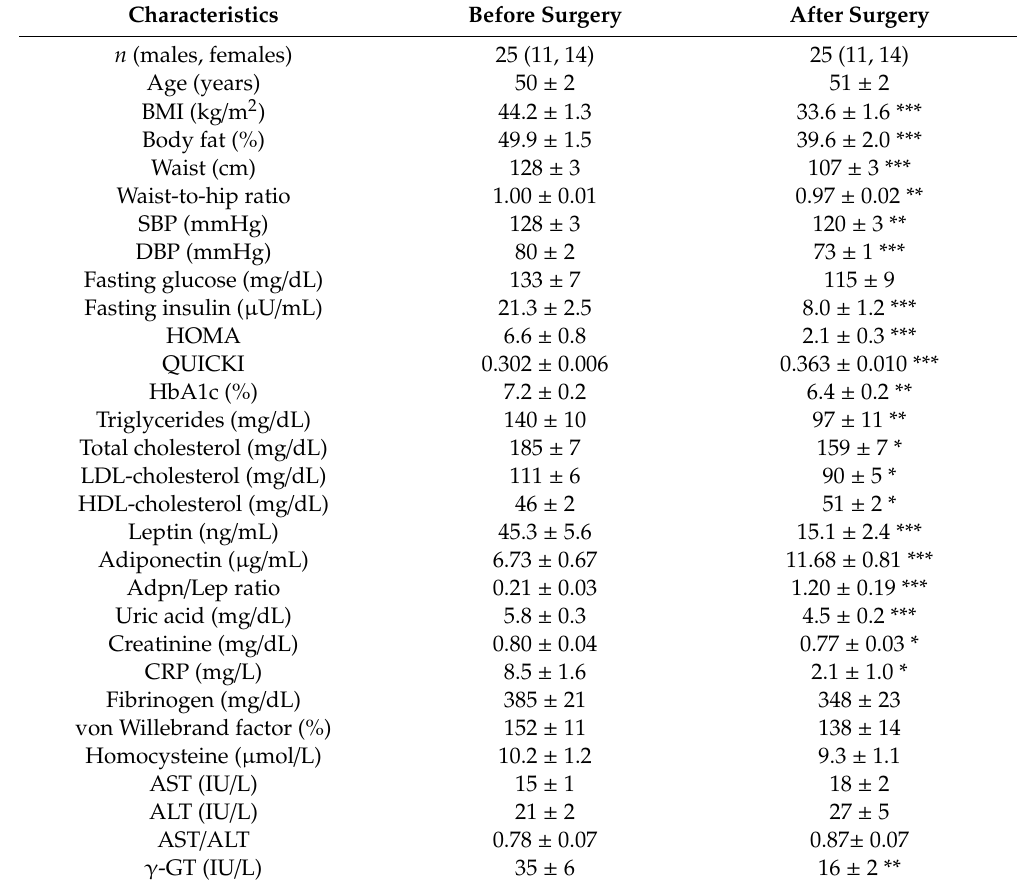
Table 1. Anthropometric and metabolic e ff ects in patients with obesity and type 2 diabetes (T2D) before and after Roux-en-Y gastric bypass (RYGB). Characteristics Before